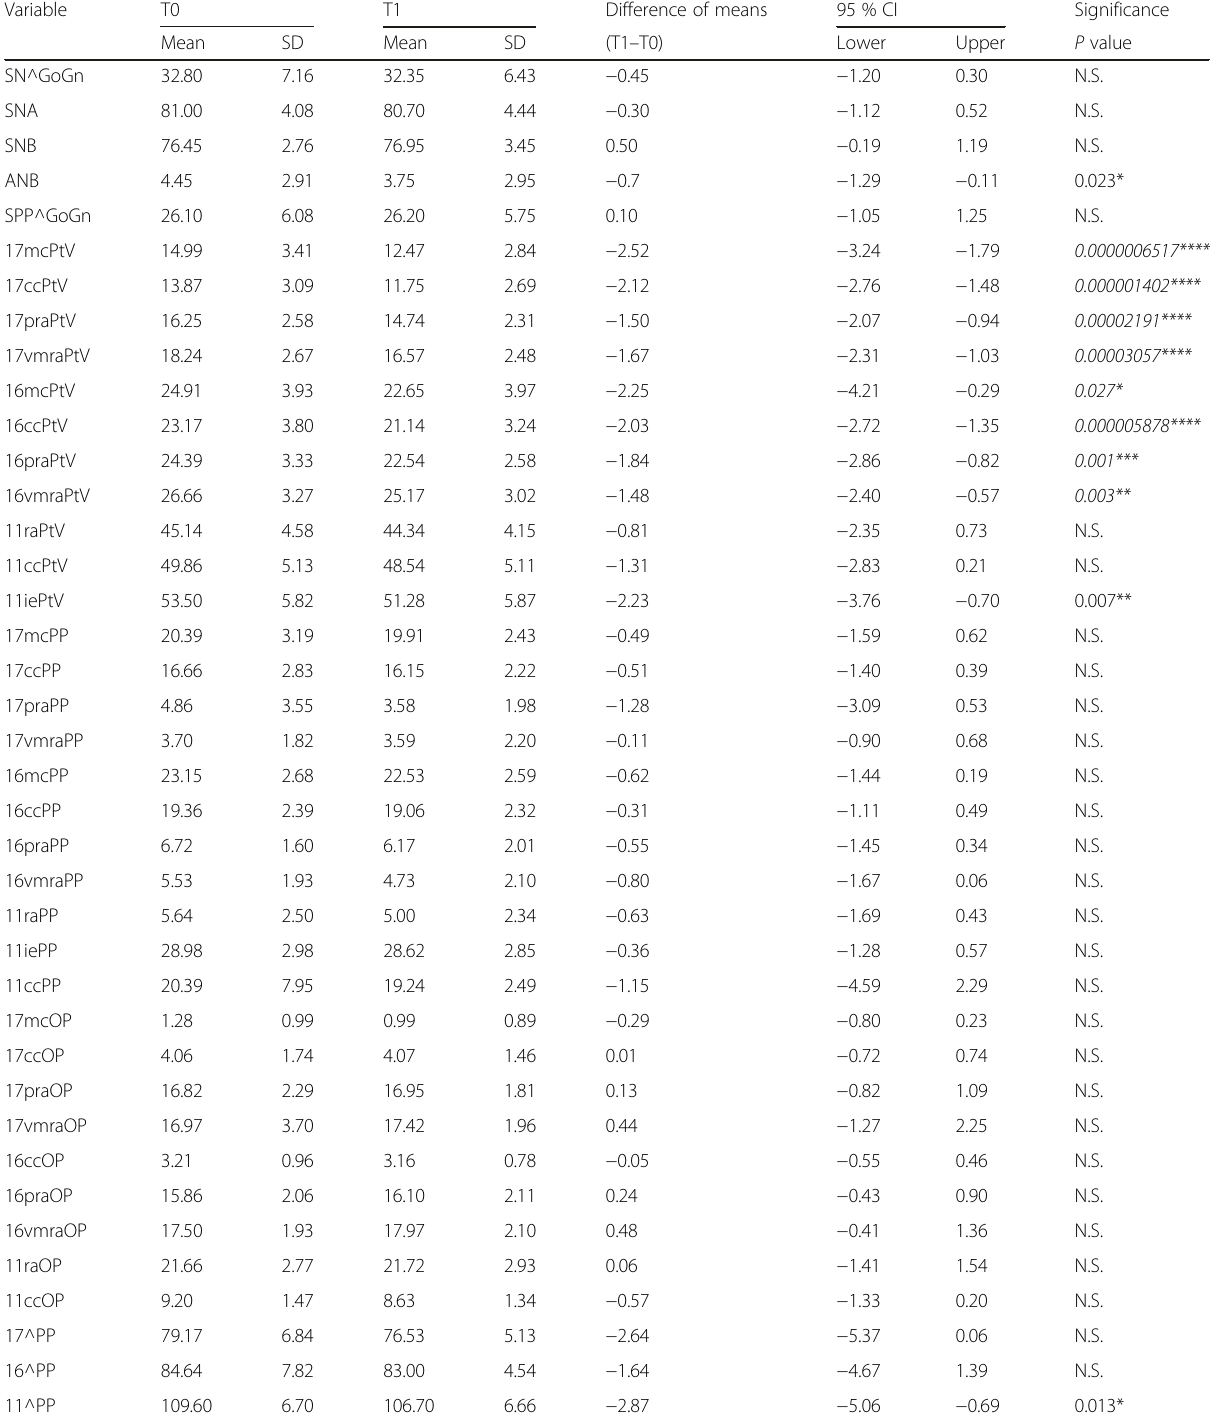
Table 1 Study group: difference of means between T0 and T1 for all the considered variables Variable T0 T1 Difference of means 95 % CI Significance SN^GoGn